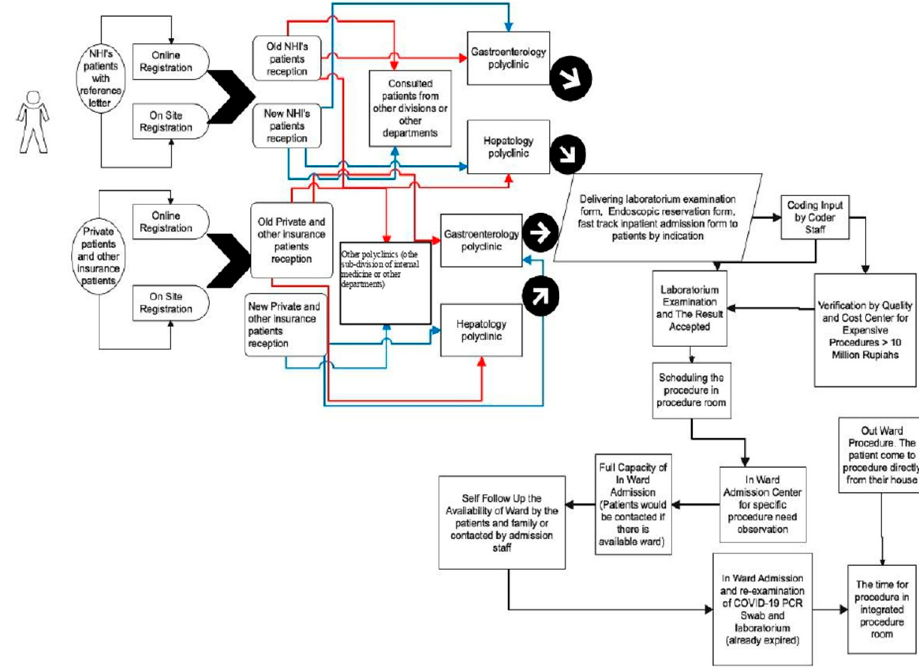
Figure 4. Entry Flow of Endoscopic Patients from Outpatient Units before the Pandemic.